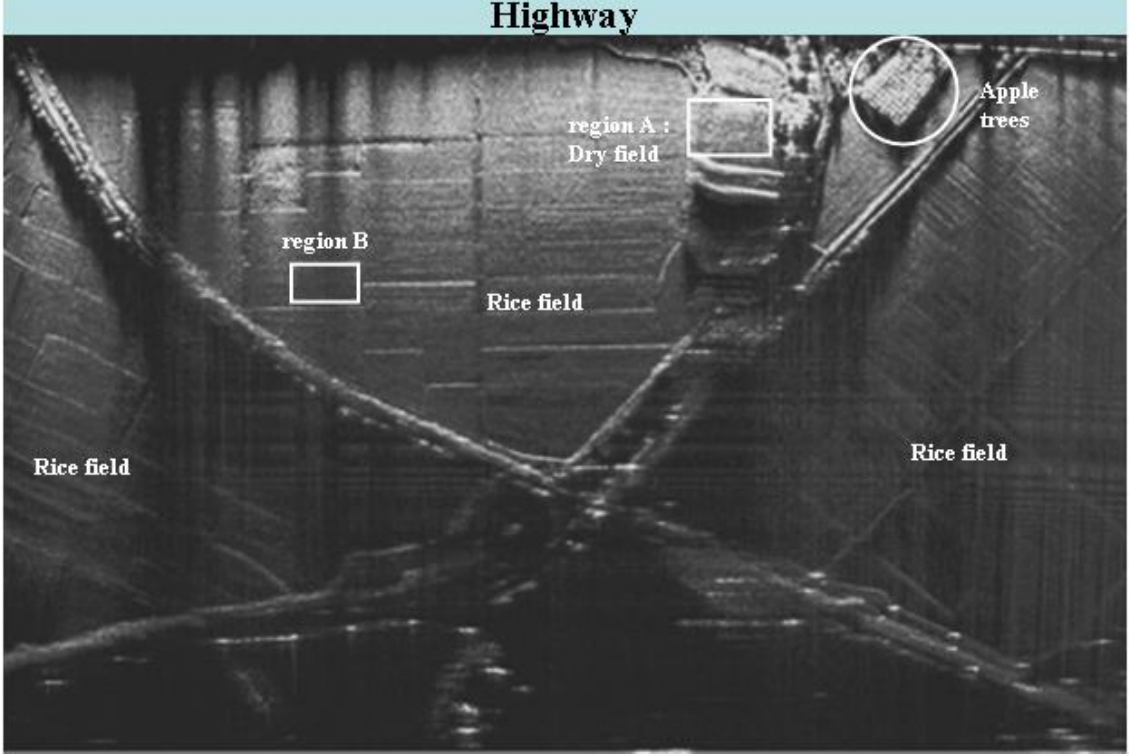
Figure 5. SAR image of a rural area obtained by AutoSAR [13]. The size of imaged area is about 800 m x 600